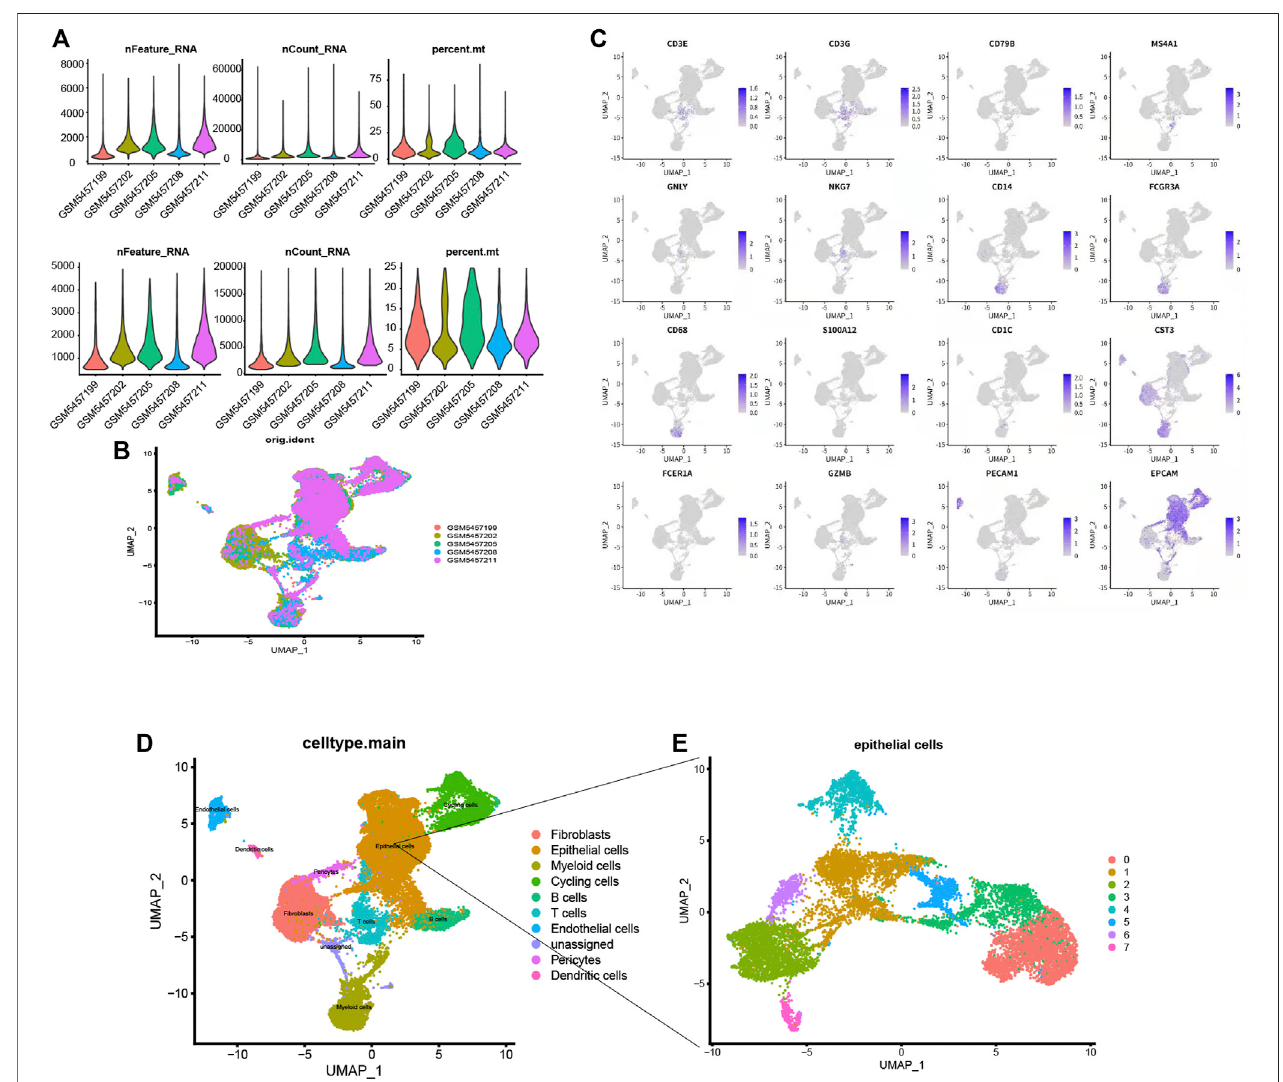
FIGURE 6 | (A) The data pre-process results. (B) . The distribution of the fi ve samples. (C) Fibroblasts, Epithelial cells, Myeloid cells, Cycling cells, B cells, T cells, Endothelial cells, unassigned, Pericytes, and Dendritic cells. For example, CD3E, CD3E, CD79B and MS4A1 (D) Subgroup annotation analysis for single cells, (E) Eight types of epithelial